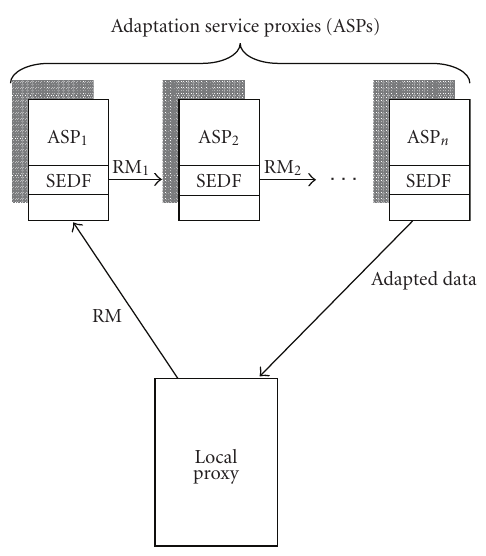
Figure 6: Decentralized services execution pattern (mesh-based).